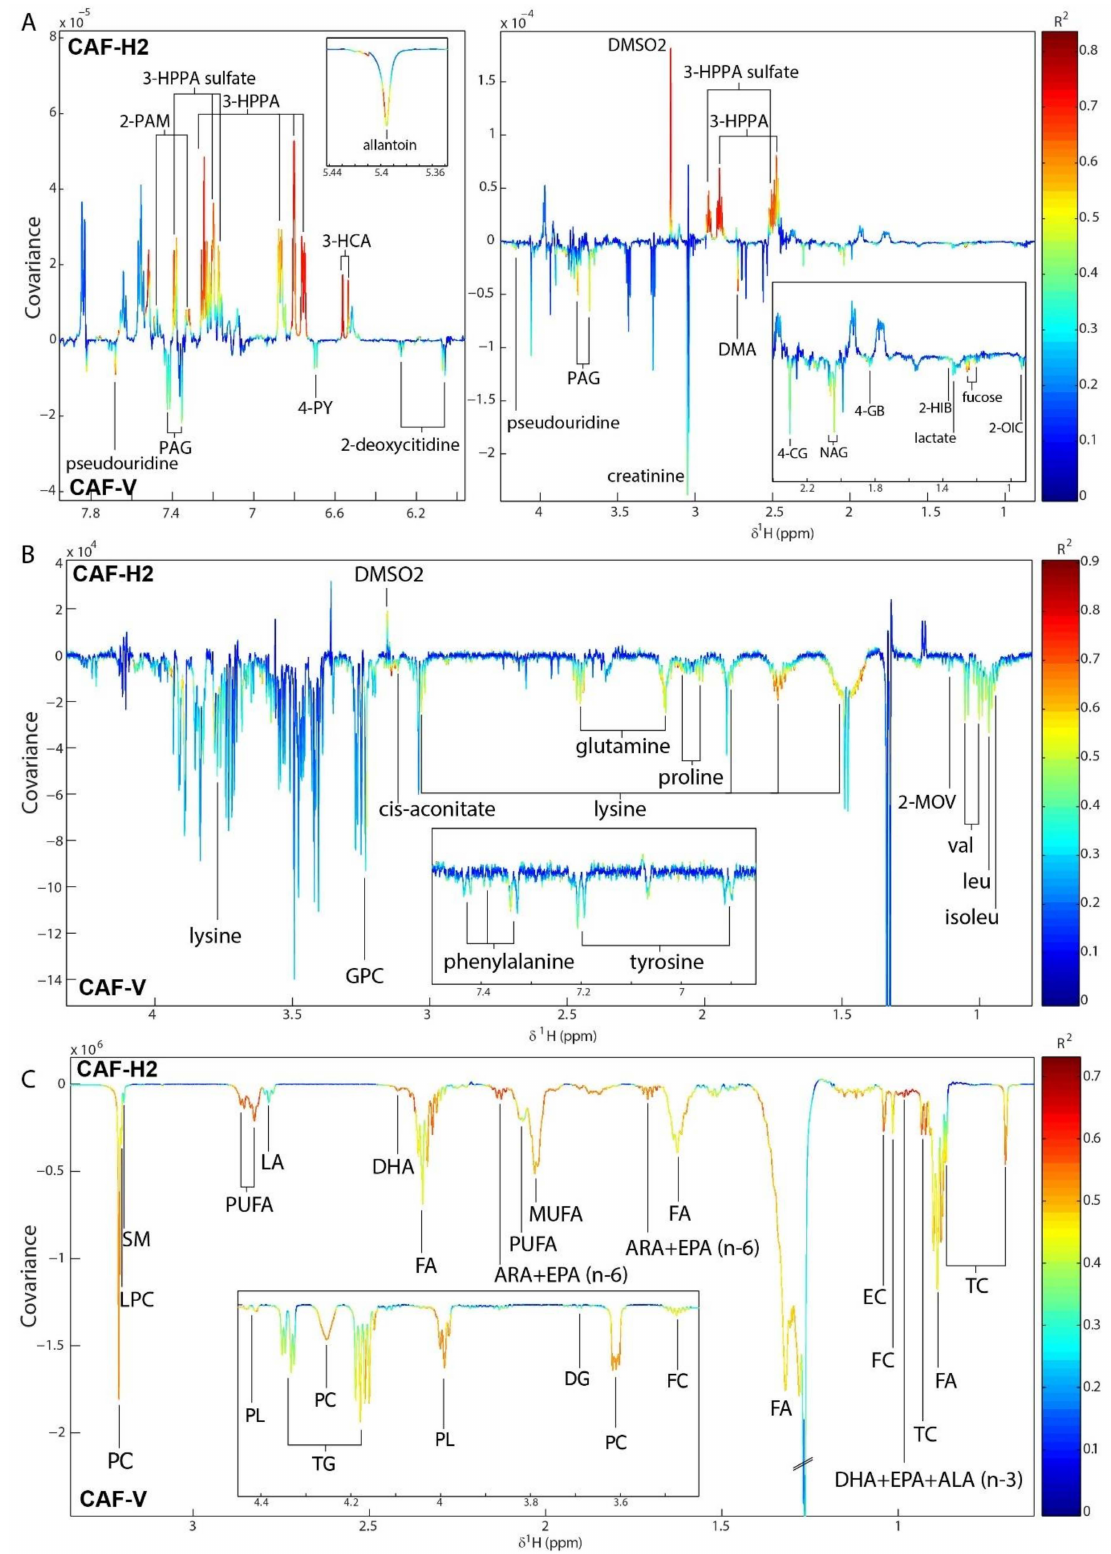
Figure 4. Orthogonal projection to latent structures-discriminant analysis (OPLS-DA) coe ffi cients plot comparing the ( A ) urine metabolic profiles, ( B ) the serum aqueous metabolic profiles, and ( C ) the serum lipid metabolic profiles of CAF-fed rats supplemented with either the vehicle (V) or hesperidin at 100 mg / kg (H2). The colour scale represents the significance of the correlation for each